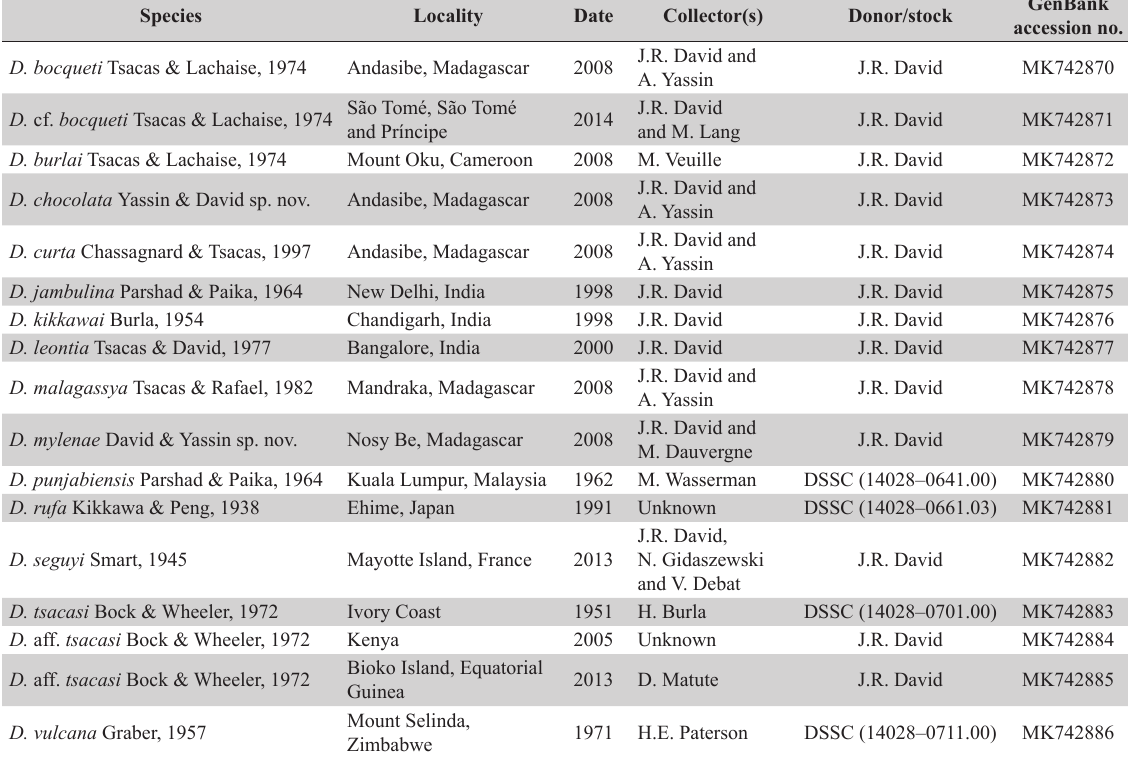
Table 1. Strains of Drosophila Fallén, 1823 used in the current study, with GenBank accession numbers of their assembled